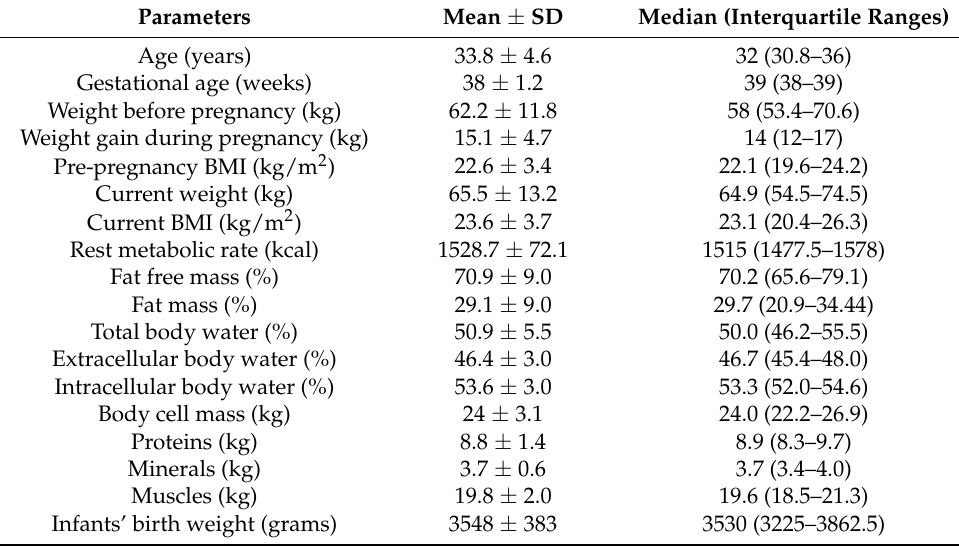
Table 3. Characteristics of the study